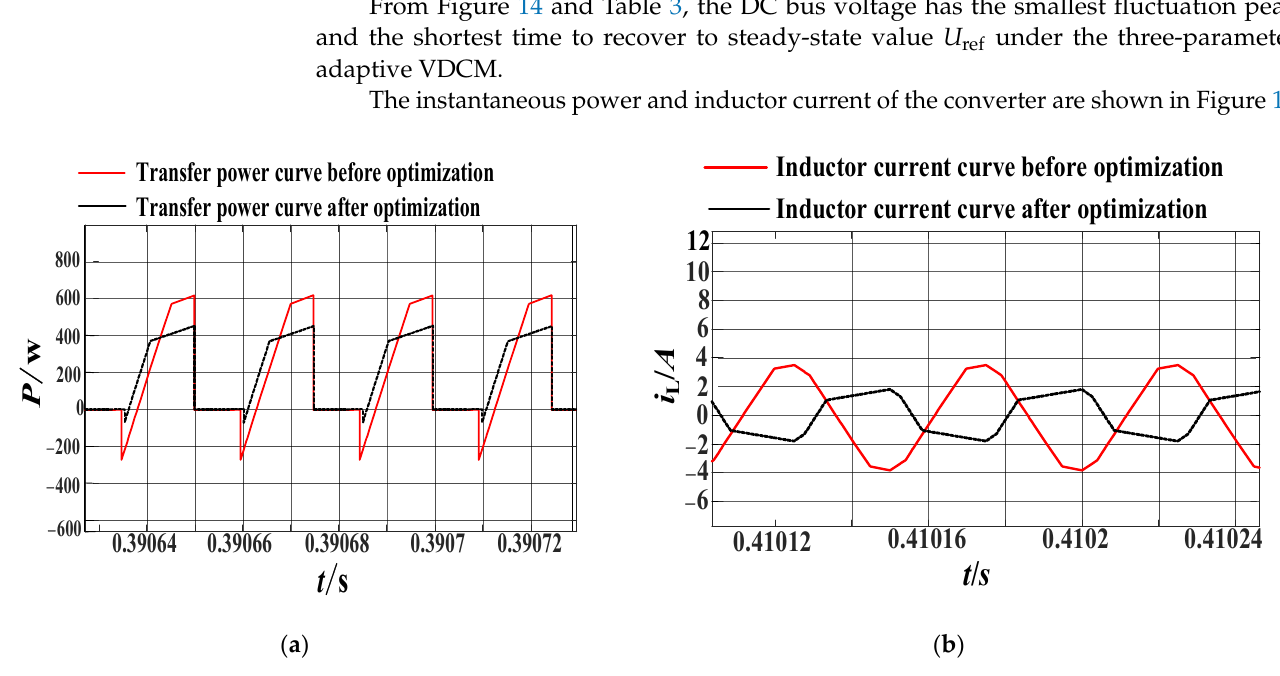
Table 4. Backflow power of converter. Backflow Power